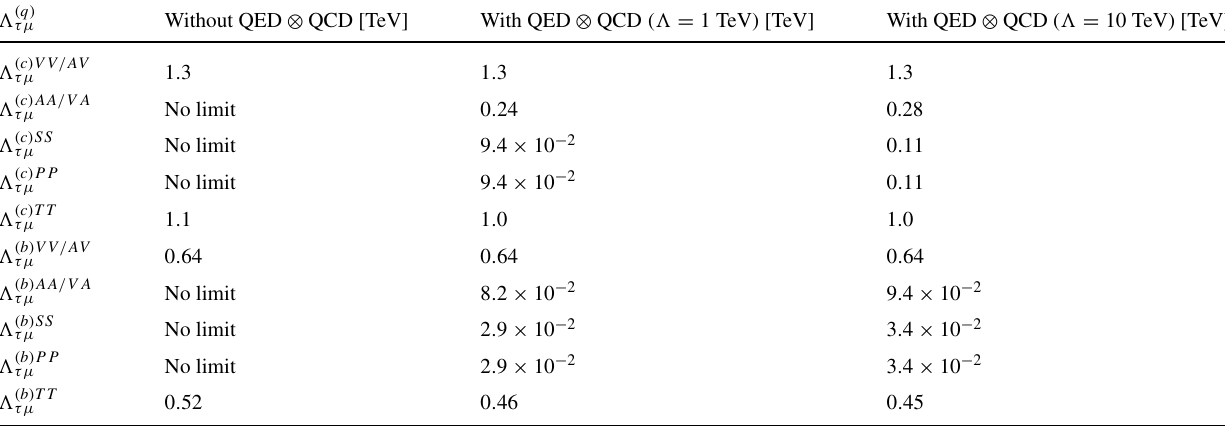
( q ) AB (cid:2) (cid:2) = τμ ) associated to the Wilson coefficient C ( q ) AB 1 2 (cid:2) 1 (cid:2) 2 (